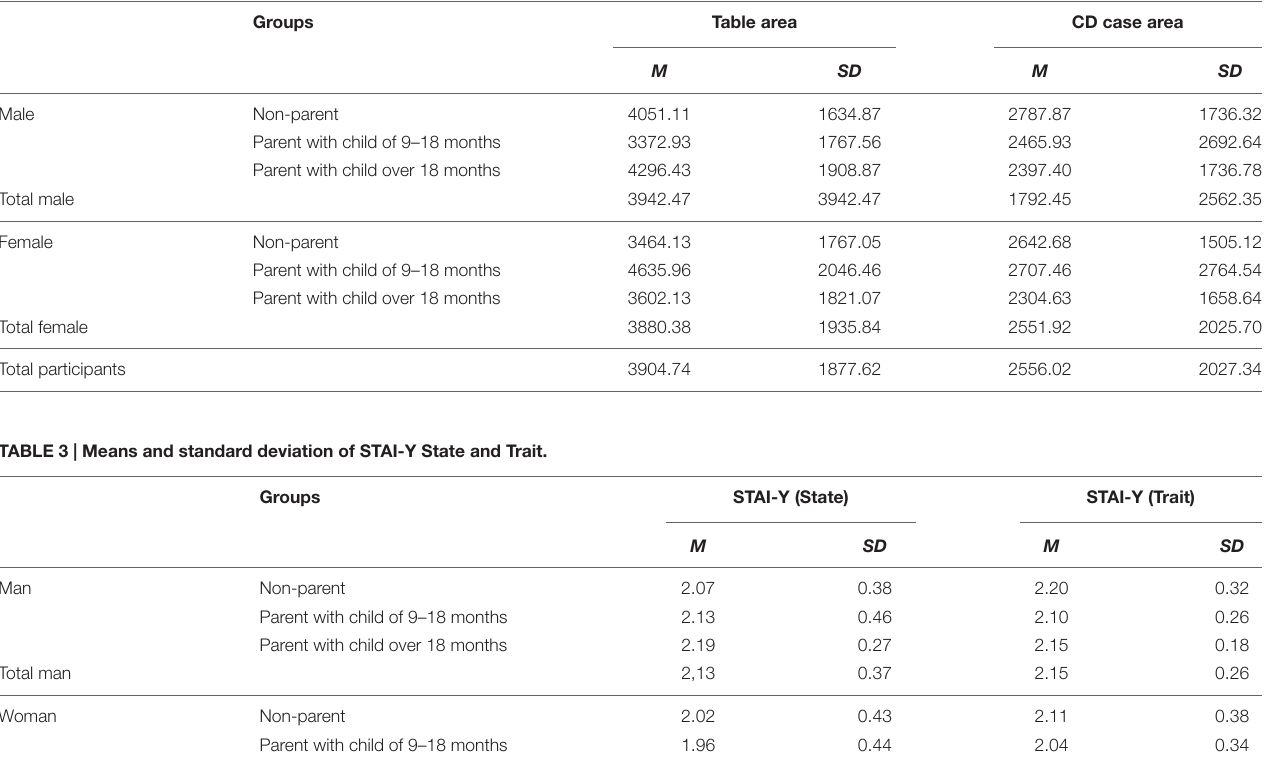
TABLE 2 | Descriptive statistics of table area and CD case area.